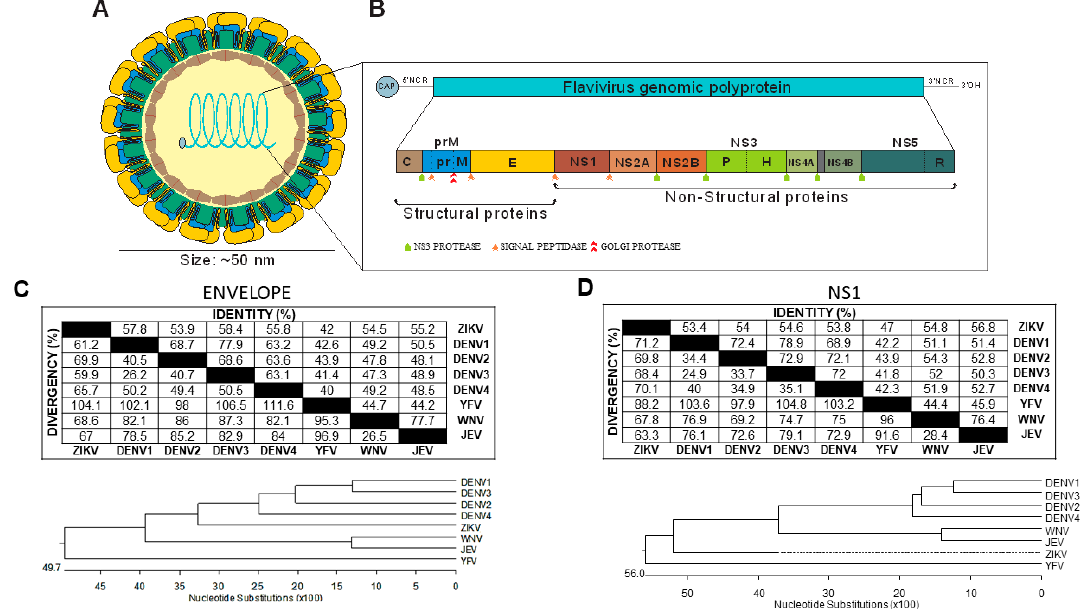
Figure 1. Genetic organization and protein homology among different flaviviruses. ( A ) Schematic representation of the virion structure. ( B ) Genome organization and polyprotein. ( C , D ) Homology profiles of Zika virus (ZIKV), Dengue virus (DENV), Yellow Fever virus, (YFV), West Nile virus (WNV), and Japanese encephalitis virus (JEV) were determined using the reference sequences of envelope (E) ( C ) or nonstructural 1 (NS1) ( D ) proteins.